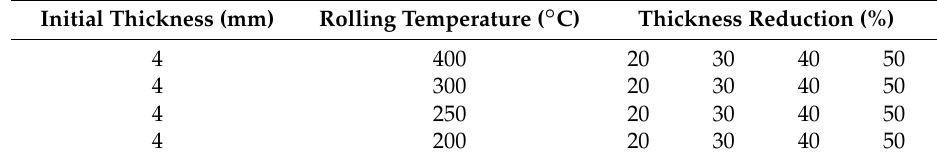
Table 1. Rolling process parameters.